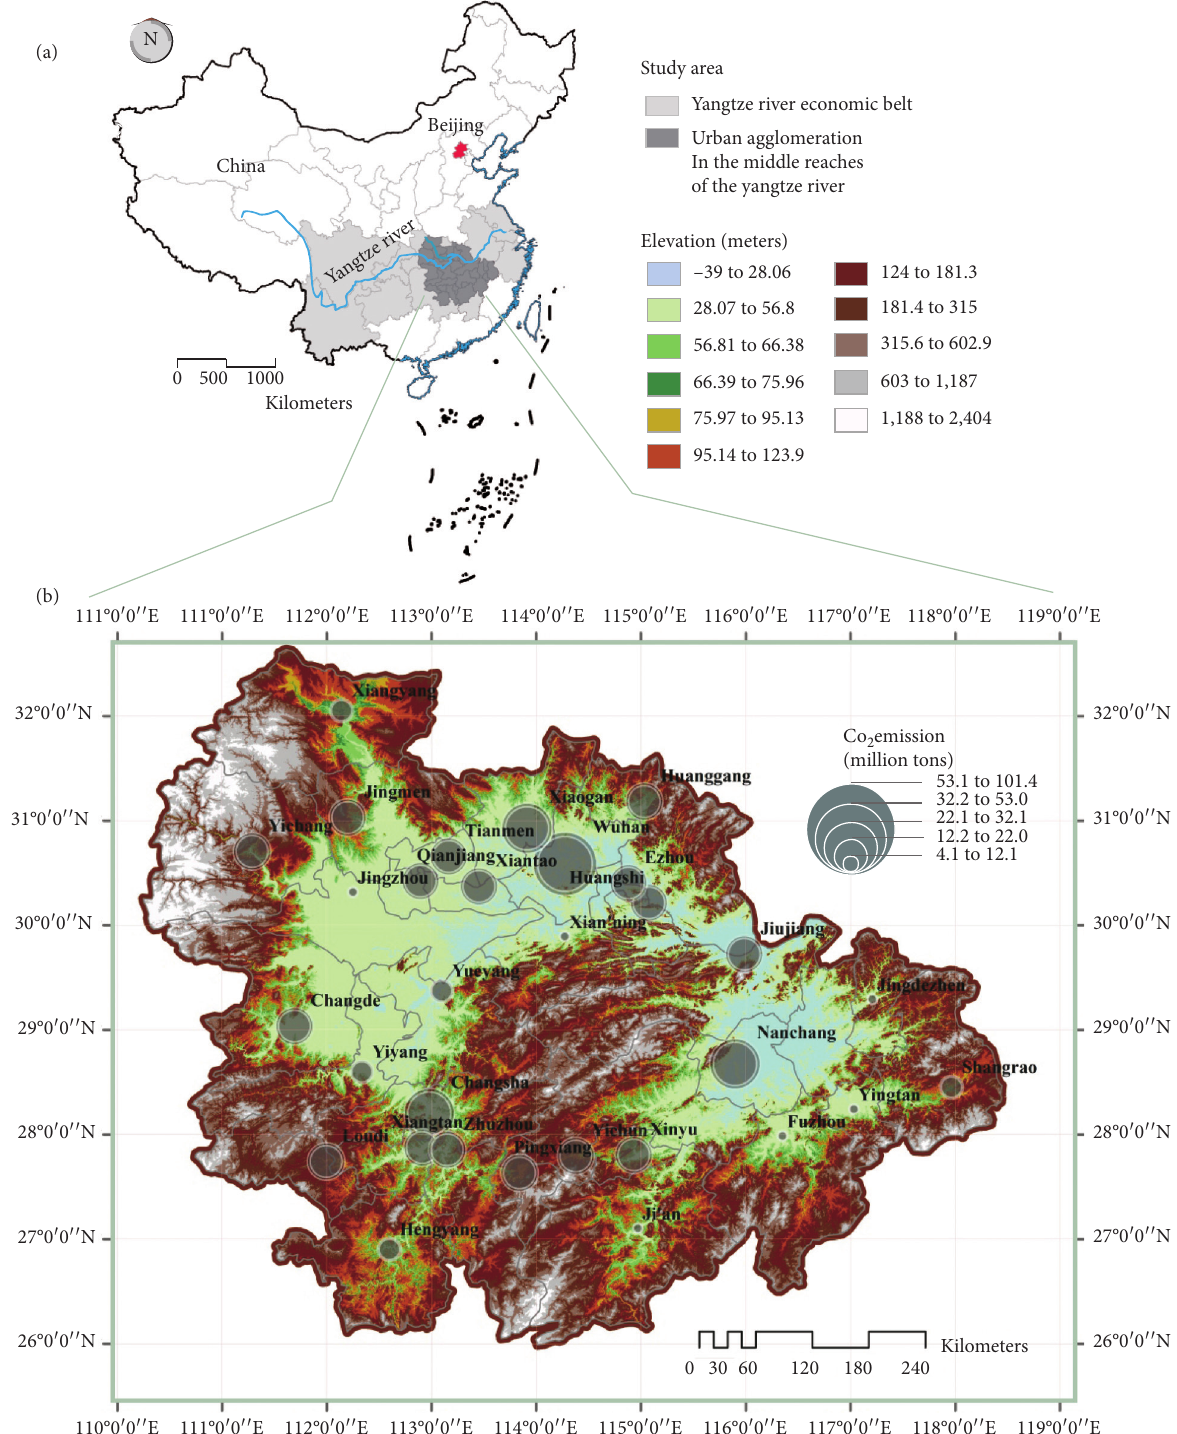
Figure 1: Location of the Yangtze River middle reaches megalopolis (a) and the cities’ CO the CO 2 emission data in the Yangtze River middle reaches megalopolis, provided by the China CO 2 emission database (http://www.ceads.